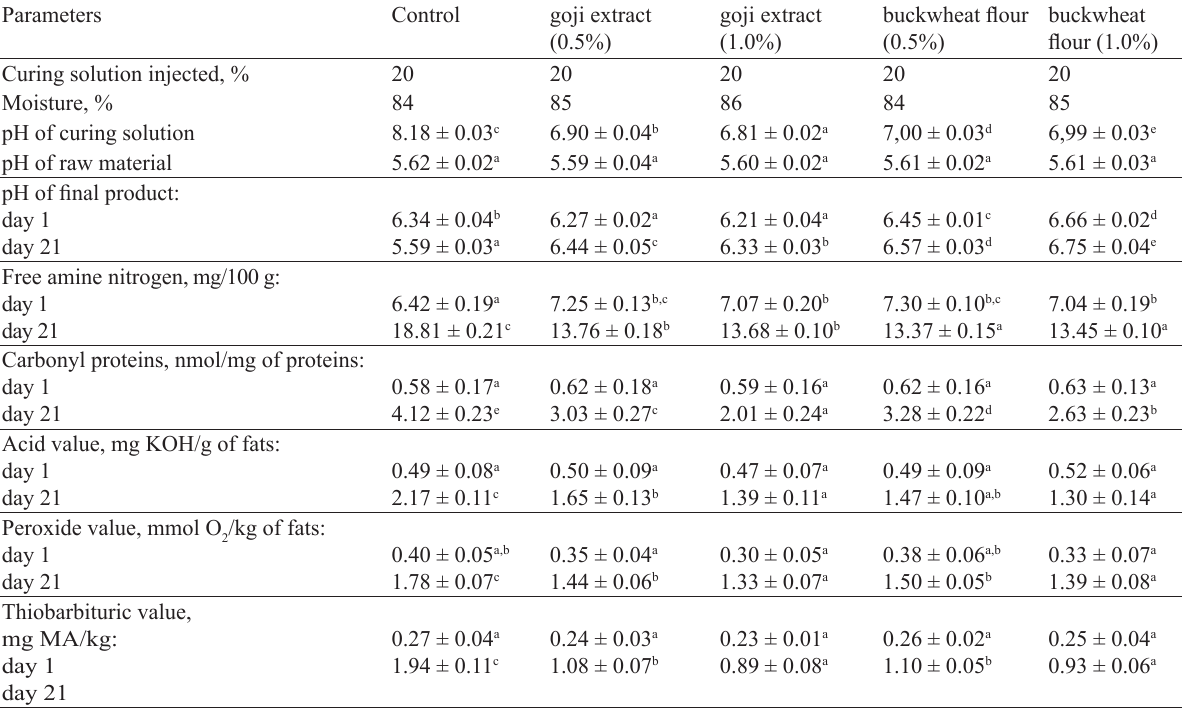
Table 3. pH, free amine nitrogen, total carbonyl proteins, acid value, peroxide value, and TBARS in vacuum-packed samples before and after 21 days of storage at 0–4°C Parameters